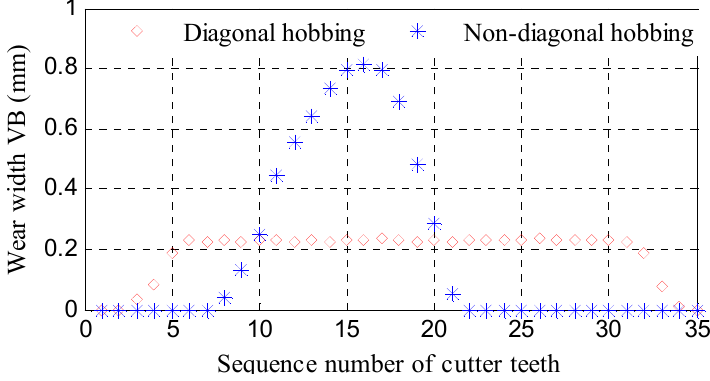
Figure 7. ( a ) Virtual hobbing of a non-circular helical gear based on the diagonal hobbing process; ( b ) 3-order elliptic helical gear hobbed using diagonal hobbing [12].